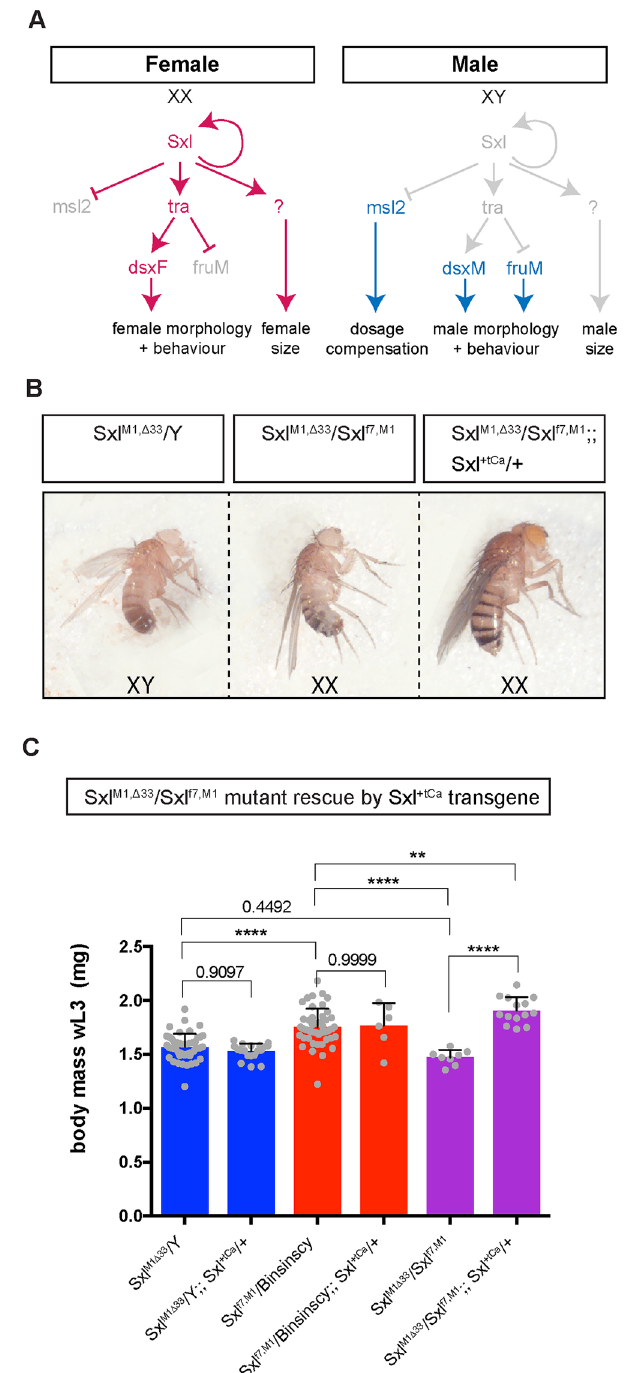
Fig 2. Sxl controls the sexual size dimorphism (SSD) of the larval body. (A) Schematic of the sex determination pathway in Drosophila and its control of sexual differentiationand dosagecompensation. Genes/proteins active in females are displayedin red; genes/proteinsactive in males are displayedin blue. (B) Transheterozygous Sxl M1 , Δ 33 /Sxl f7 , M1 mutant female adults are masculinisedin terms of morphology and body size (middlepanel). Both morphologyand body size can be rescuedby a wild-typecopy of the Sex-lethal ( Sxl ) gene, Sxl +tCa (right panel). (C) Sxl M1 , Δ 33 /Sxl f7 , M1 mutant female larvaeare also masculinised in terms of larval body mass, and this can be rescuedby Sxl +tCa , showingthat Sxl functions to control larval SSD. Individual data points, means, and SD are plotted. Asterisks denote significantchangesaccordingto a